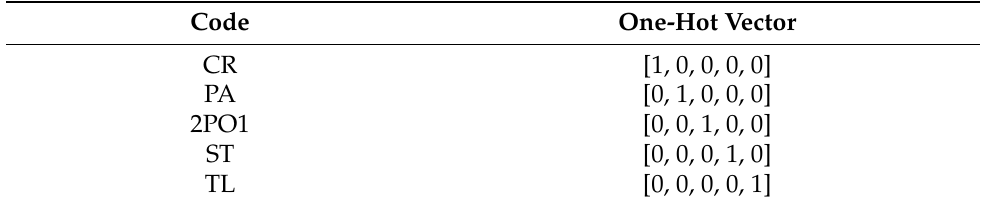
Table 2. Labeling transformation. The room information label is transformed to one-hot vector with the aim of addressing the CNN classification